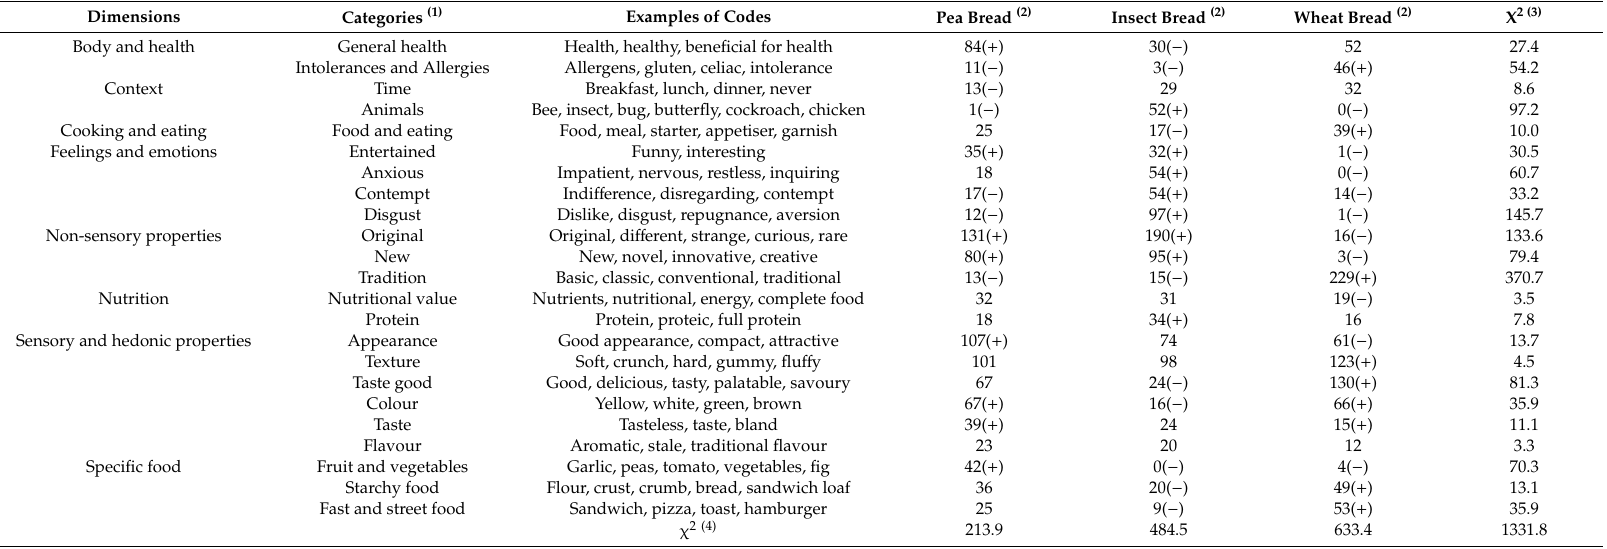
Table 5. Contingency table with the main dimensions, categories and example of codes elicited by respondents to bread presented; the number of citations per stimuli and results of the Chi-squared per cell